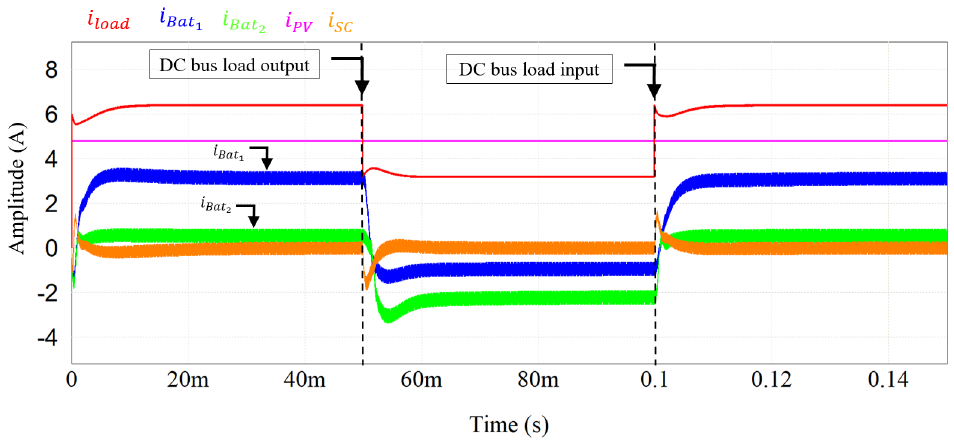
Figure 10. Dynamic and static response currents of system with FBM-CSoC